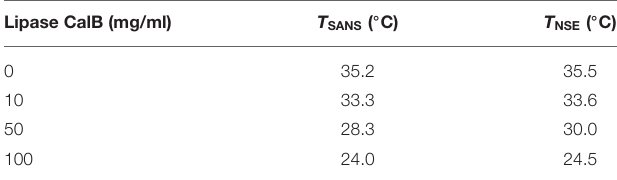
TABLE 1 | Temperature conditions of the experiments. Lipase CalB (mg/ml)